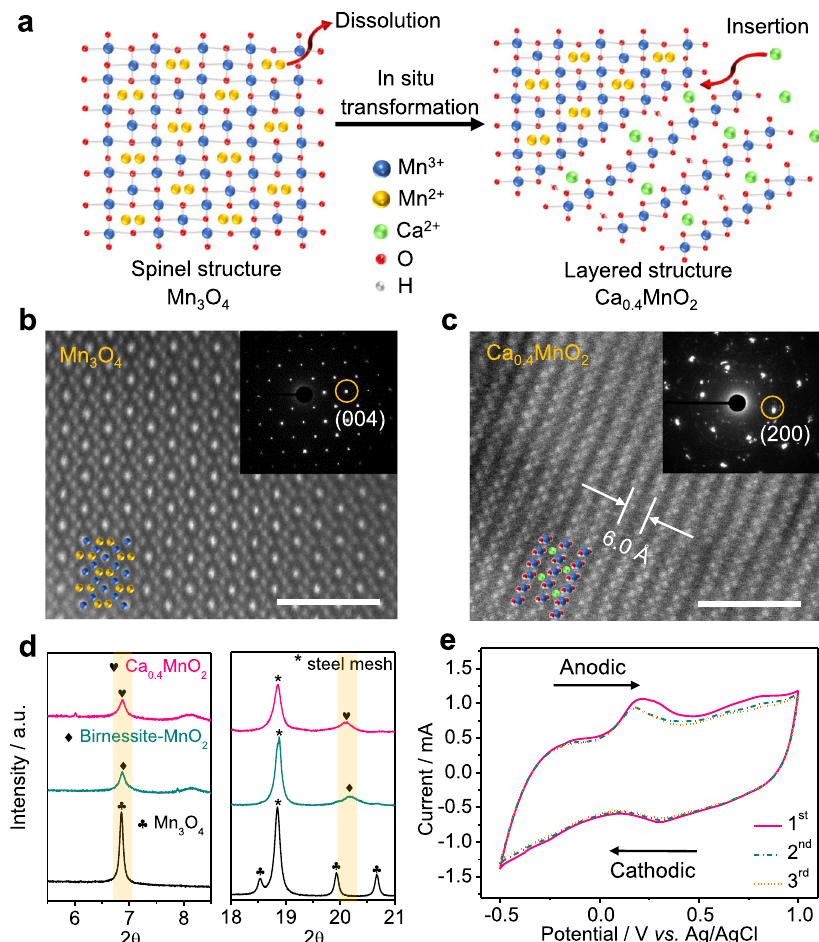
Fig. 4 Characterization of the Ca 0.4 MnO 2 cathode. a Schematic illustration of the atomic structure change during the in situ electrochemical conversion. The HADDF – STEM images of b the Mn 3 O 4 precursor and c The Ca 0.4 MnO 2 cathode material. Blue, orange, green, and red balls represent Mn 3 + , Mn 2 + , Ca, and O atoms, respectively. Scale bars are 2 nm in Fig. 4b and c. d Synchrotron powder diffraction patterns of the Mn 3 O 4 , birnessite MnO 2 , and Ca 0.4 MnO 2 . The peaks marked with star symbol correspond to the stainless-steel mesh current collector. e CV curves of the Ca 0.4 MnO 2 cathode collected at a scan rate of 0.3 mV s – 1